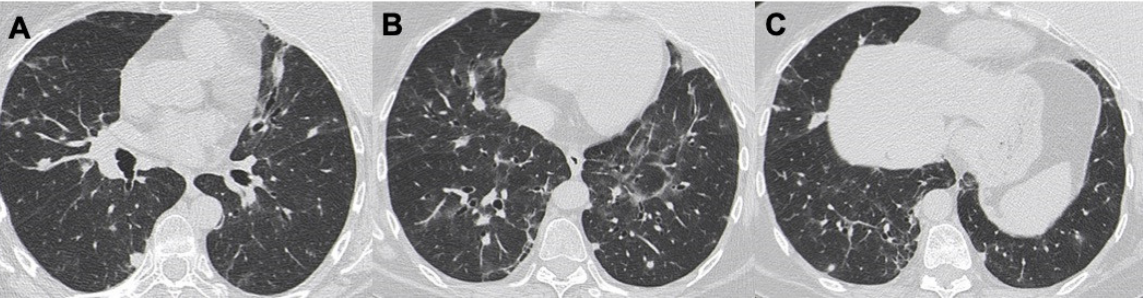
Figure 3. Images in ( A – C ) demonstrate the presence of diffuse rounded nodules in the peribronchovascular bundles; also, perilobular “atoll sign” is present, showing an “OP-like” pattern (OP: organizing pneumonia).